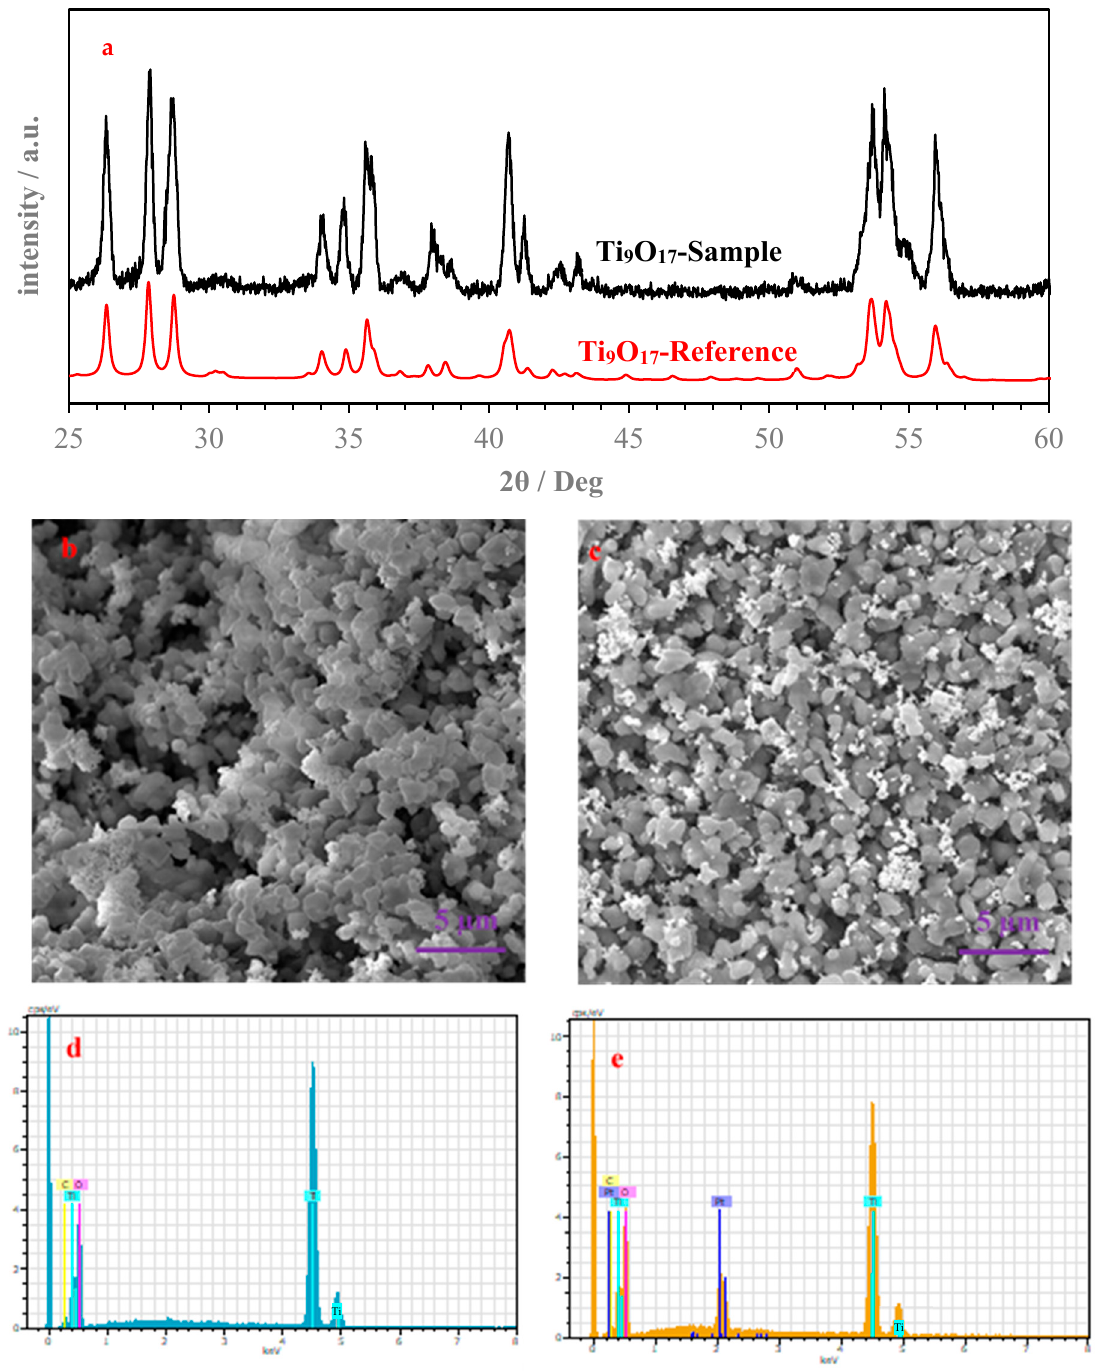
Figure 2. ( a ) XRD spectra of Ti 9 O 17 along with a reference (ICSD # 035124) spectrum. SEM images of ( b ) Ti 9 O 17 and ( c ) Pt/Ti 9 O 17 . EDS spectra of ( d ) Ti 9 O 17 and ( e ) Pt/Ti 9 O 17 .